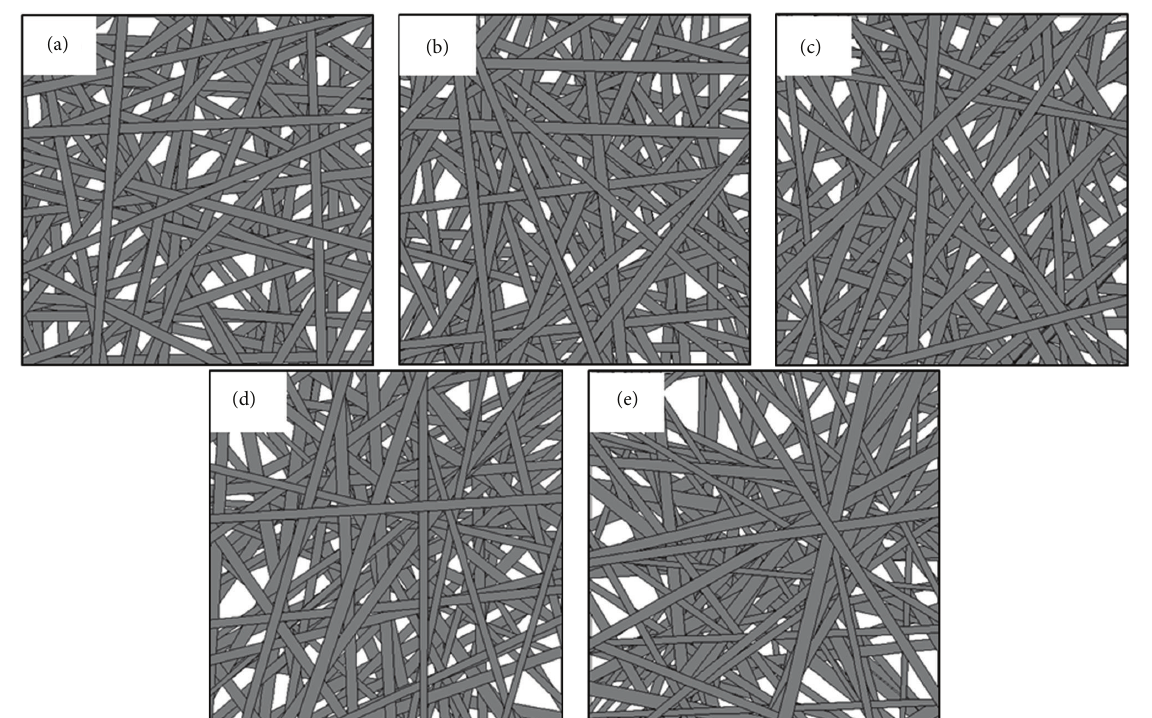
Figure 3: Nanofibrous structures with various size polydispersity: (a) monodisperse size of 𝑑 𝑓 , (b) 0.85𝑑 𝑓 – 1.15𝑑 𝑓 , (c) 0.75𝑑 𝑓 – 1.25𝑑 𝑓 , (d) 1.35𝑑 0.55𝑑 1.45𝑑 0.65𝑑 𝑓 – 𝑓 , and (e) 𝑓 – 𝑓 .